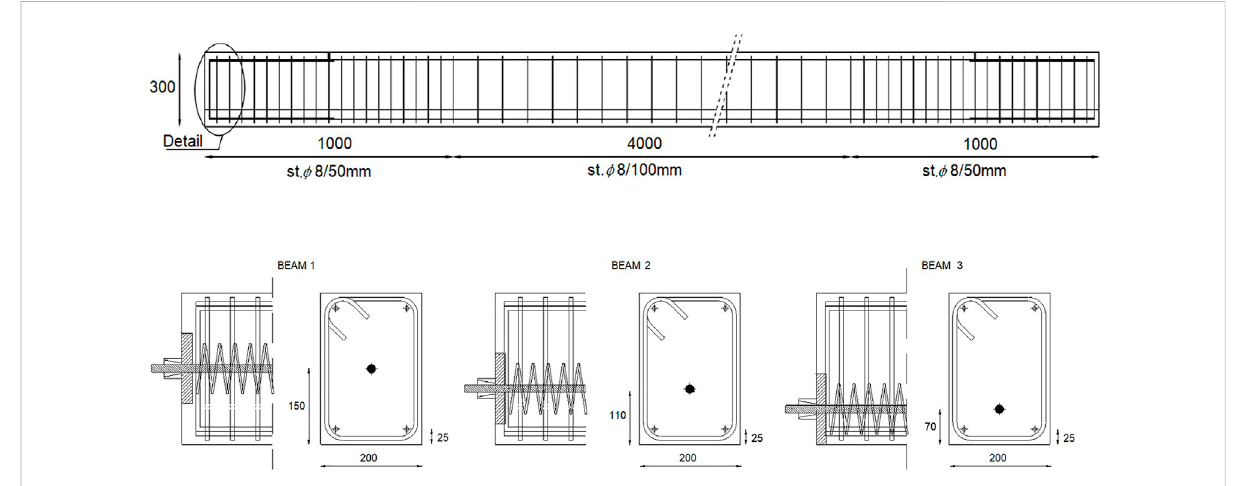
FIGURE 1 Laboratory PTC beams geometry and reinforcement